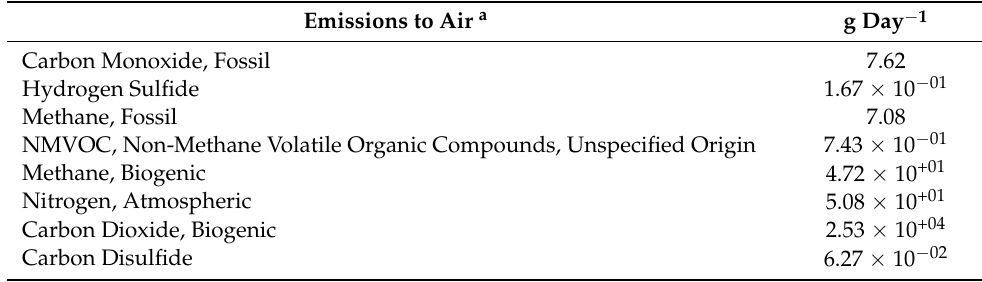
Figure 6. Mass and energy flow diagram of the tonnes of residual biomass fed per day for C-7. The grey dotted lines and boxes show the fuels, energy and resources referred from databases. Table 4. Atmospheric emissions from the biogas combustion in the biogas engine.